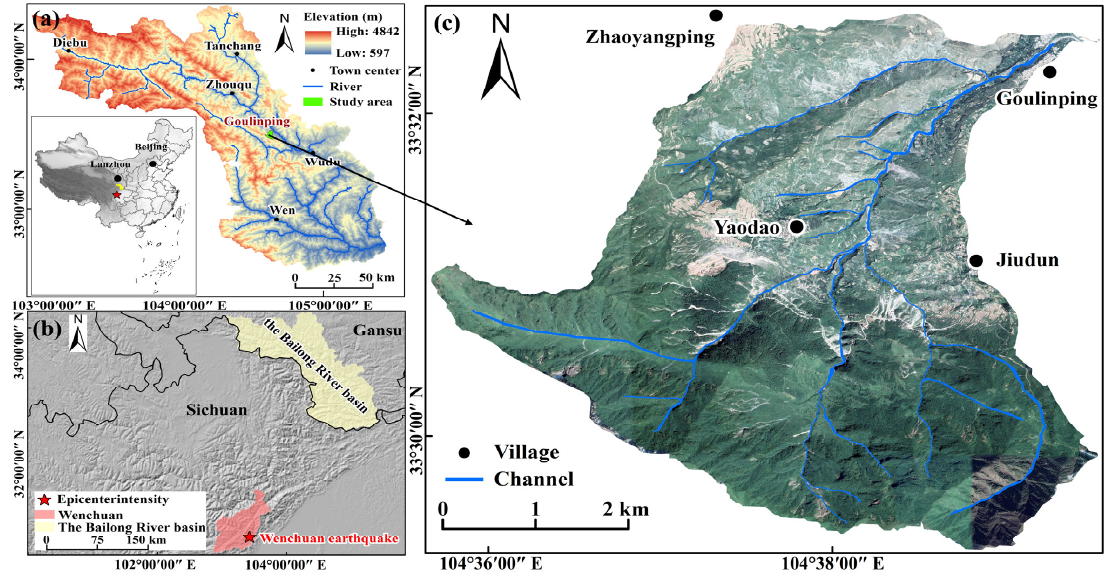
Figure 1. Location of the study area. ( a ) Location of the Bailong River basin; ( b ) location of the Wenchuan earthquake epicenter; ( c ) location of the GLP (the optical image was produced in 2019).